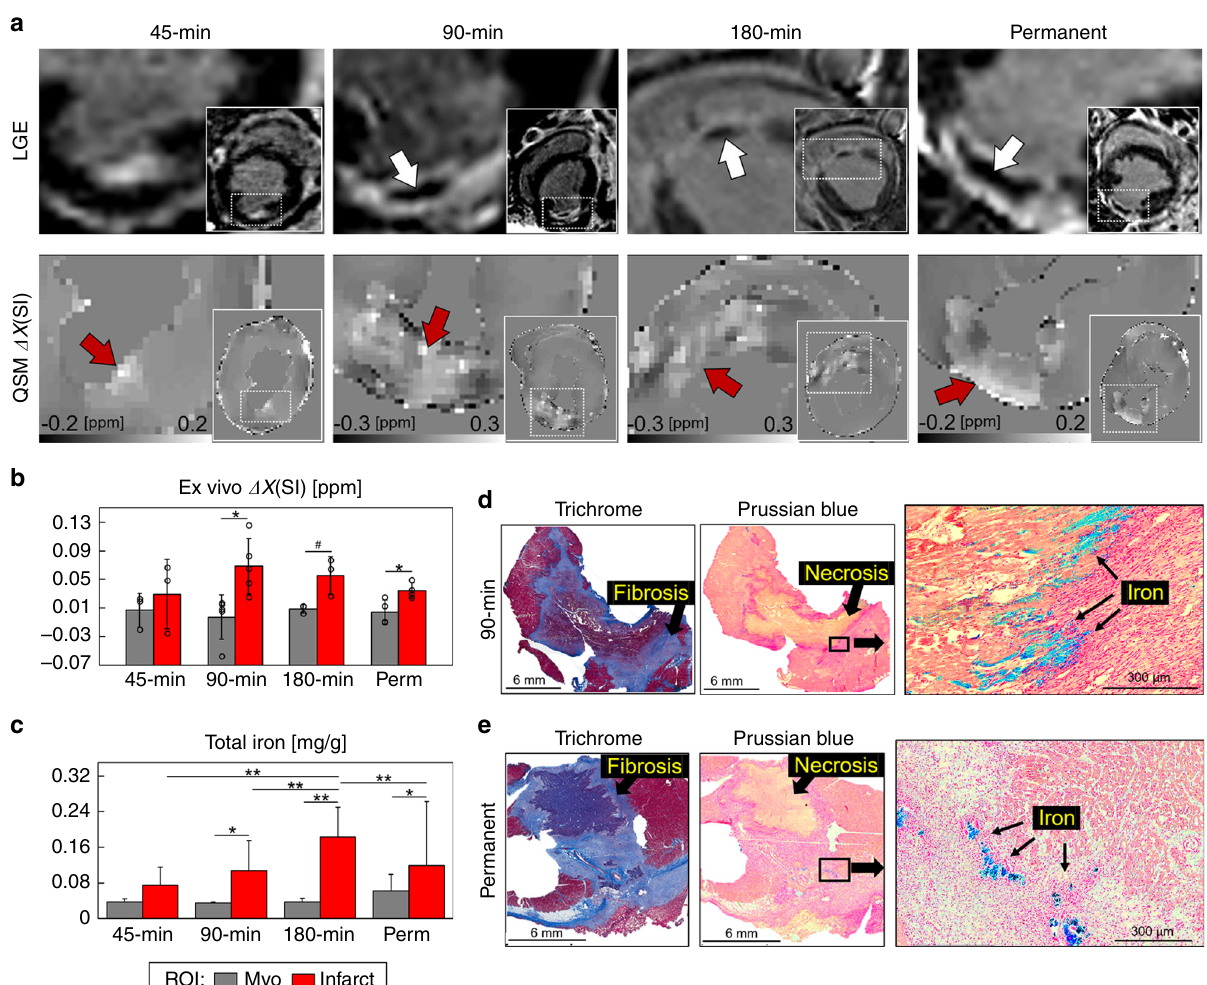
Fig. 1 Infarct magnetic susceptibility is associated with elevated tissue iron content. At 1 week post-infarction ( a ), late gadolinium enhanced (LGE) MRI shows hyperintense signal in the infarct region corresponding to uptake of gadolinium contrast agent. In total, 90, 180 min, and permanent infarcts were larger with microvascular obstruction, as indicated by hypointense regions in the infarct core (white arrows). Images show views of the infarct region and left ventricular short axis (insets). Infarcts show a paramagnetic shift in ex vivo quantitative susceptibility maps (QSM) for each infarct group compared with remote (myo) regions. b There was a signi fi cant infarct paramagnetic shift in 90 min ( P = 0.012) and permanent ( P = 0.025) infarct groups. Magnetic susceptibility measurements in 45 min ( n = 3), 90 min ( n = 5), 180 min ( n = 3), and permanent ( n = 4) infarct groups were from independent whole heart ex vivo specimens, regions of interest (ROI) were compared using a two-tailed two-sample t test for each infarct group. c Infarct total iron concentration was signi fi cantly elevated in 90 min ( P = 0.001), 180 min ( P < 0.0001), and permanent ( P = 0.015) infarcts compared with remote myocardium. In total, 45 min ( n = 31, 24), 90 min ( n = 32, 32), 180 min ( n = 48, 37), and permanent ( n = 30, 50) measurements were from independent tissue samples (myo, infarct), tissue regions and infarct groups were compared using two-way analysis of variance (ANOVA) with Tukey ’ s HSD post-hoc test. d Representative histological fi ndings in a 90 min reperfused infarct. Trichrome stain shows a nontransmural infarct, fi brosis, and nonviable myocytes at the core of the infarct. Prussian blue staining shows iron accumulation (black arrows) at the transition zone between necrotic myocytes and mixed viable myocytes suggesting an active immune response originating outside the infarct core. e Representative histological fi ndings in a permanent occlusion infarct. Trichrome stain shows fi brosis and transmural infarct. Prussian blue shows iron deposits at the peripheral infarct fi brotic regions. Representative histology from each infarct group and remote myocardium are shown in Supplementary Fig. 6. Histology was repeated independently on multiple tissue sections ( n > 5) for each whole heart specimen ( n = 15) showing similar histopathological fi ndings for each infarct group. The results are reported as mean ± SD. # P = 0.094 and signi fi cance * P < 0.05 and ** P < 0.001. Source data for b and c are provided as a Source data fi iron measurements from ICP-OES ( P = 7e − 22) and chain ( FTH1 ) expression was not signi fi cantly modi fi ed in infarct desferrioxamine-chelatable labile iron from EPR ( P = 3e − 4) compared to remote area in any of the conditions studied (Fig. 2a and Supplementary Fig. 8b). To con fi rm the increase of (Fig. 2b). The expression of the intracellular iron sensor Iron iron, we tested the gene expression of cellular iron metabolism Regulatory Protein 2 ( IRP1 , also known as ACO1 ) was markers in infarct ( n = 24) and remote myocardium ( n = 20) signi fi cantly decreased in the infarct region (infarct, 61.4% Myo tissue samples. Ferritin is a scavenger of intracellular labile iron, vs. remote myocardium, 102.4% Myo, P = 0.035) (Fig. 2c). arresting its redox activity. Ferritin light chain ( FLC ) expression Divalent metal transporter 1 ( DMT1 ), which transports iron into signi fi cantly increased in the infarct (infarct, 1137.2% Myo vs. the labile iron pool, was signi fi cantly decreased in the infarct remote myocardium, 88.1% Myo, P = 0.002) and ferritin heavy region (infarct, 53.7% Myo vs. remote myocardium, 99.1% Myo,